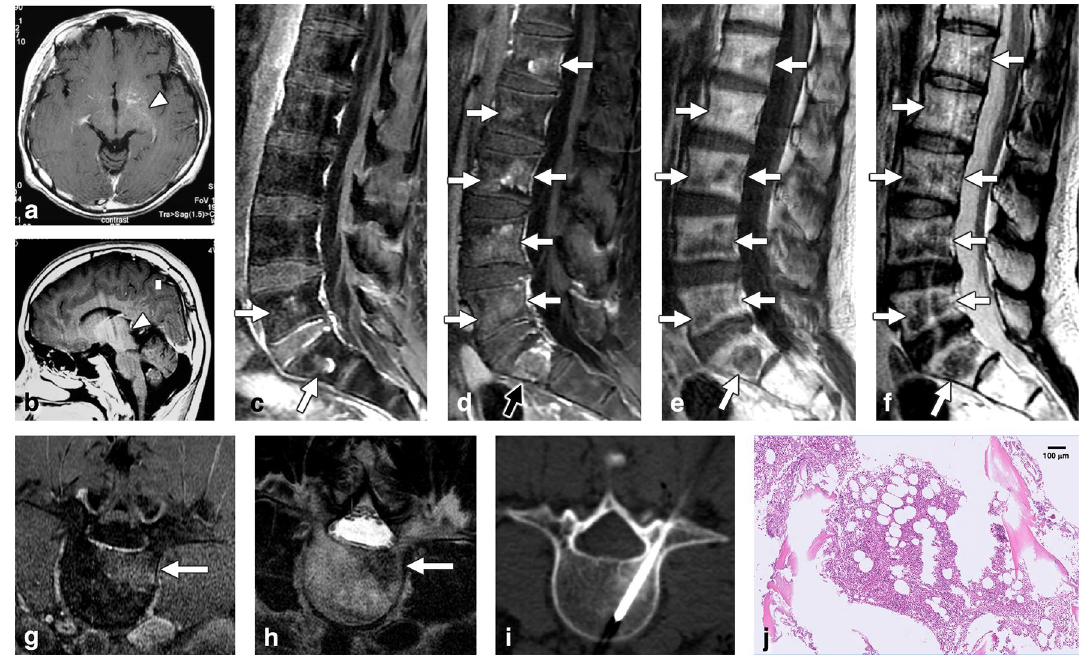
Figure 3. Indolent enhancing spinal lesion (IESL)—Case 3. An 11-year-old boy had a germ cell tumor over the thalamus to the hypothalamus ( a , b ). He had completed radiotherapy and chemotherapy. Seventeen